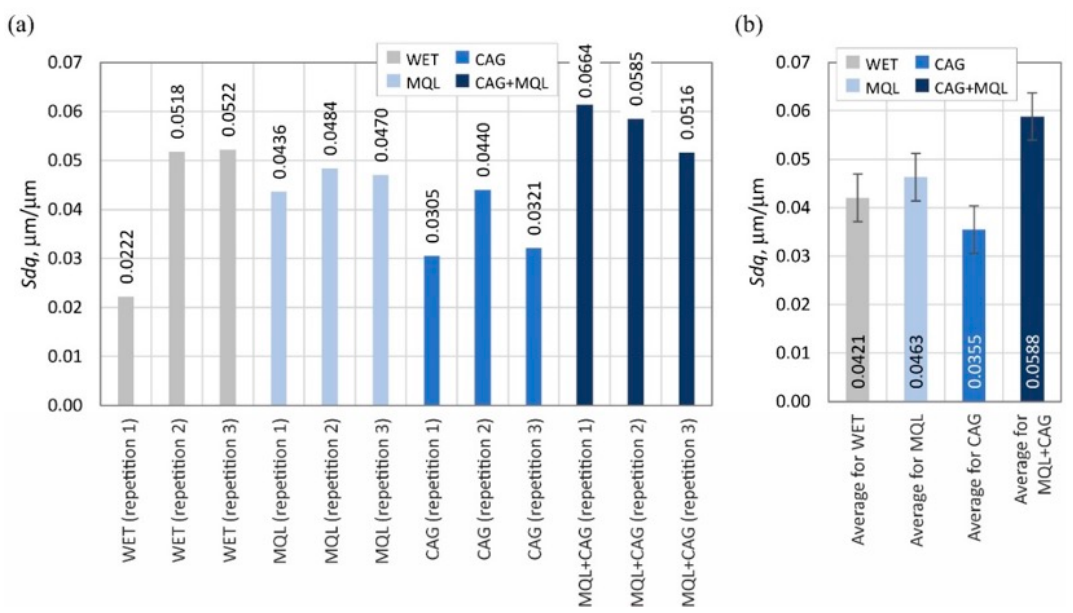
Figure 12. Chart of changes in the root-mean-square slope of the surface Sdq : ( a ) results for the twelve blades selected for the surface texture measurements; ( b ) mean values of the parameters divided by cooling and lubrication methods of the grinding zone used during the shaping of the blades (error bars represent the standard error equal to the standard deviation σ divided by the square root of the total number of samples).